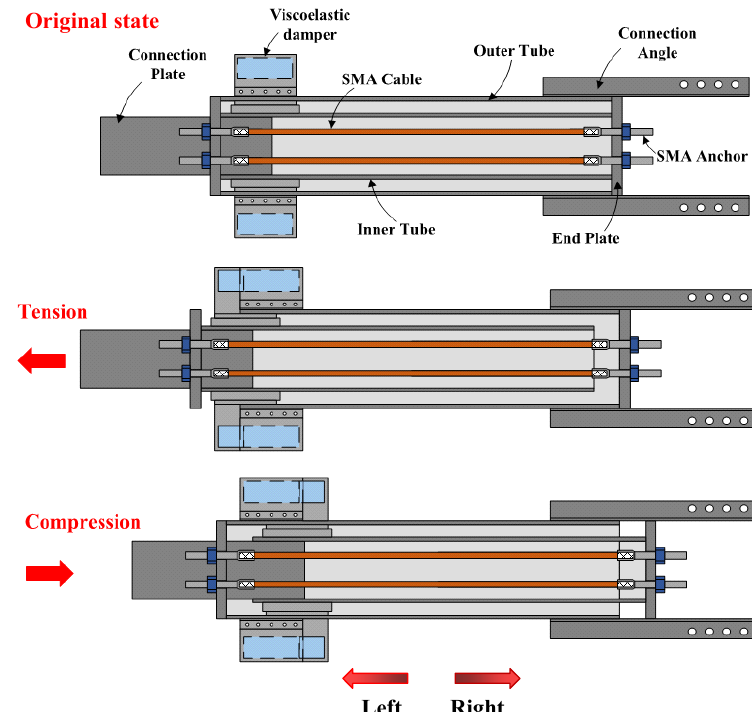
Figure 2. Working principle of SCVEB.